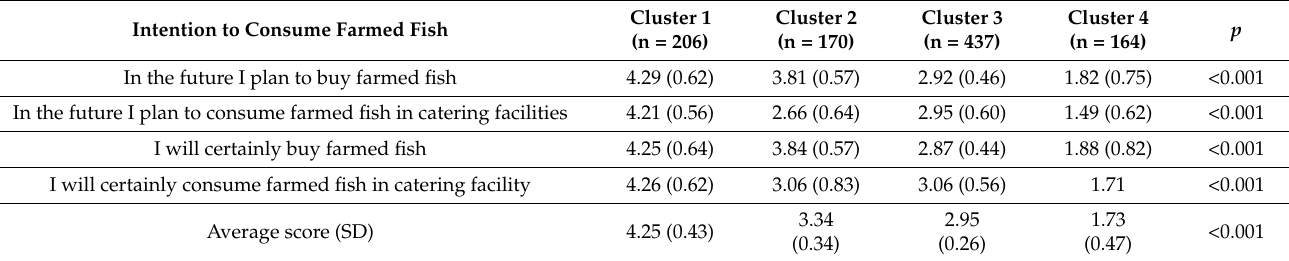
Table 1. Intention to consume farmed fish among Croatian fishery consumers (n =